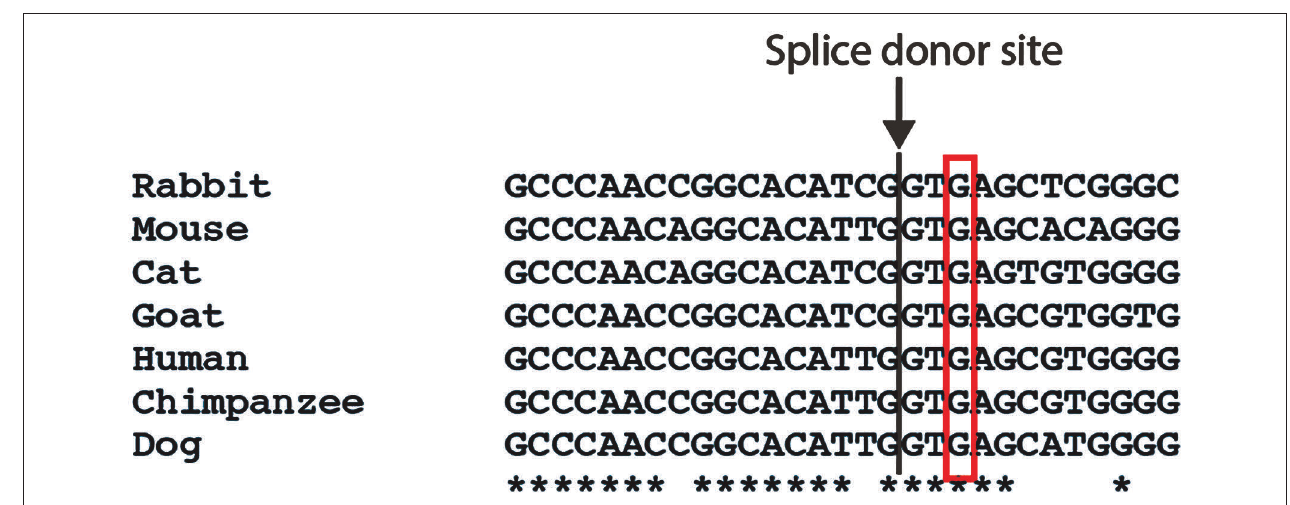
cytoskeleton network (29). Not only the innate defects of the Z disc-associated proteins lead to MFM pathology, disturbance of the turnover homoeostasis of these constitutive proteins also